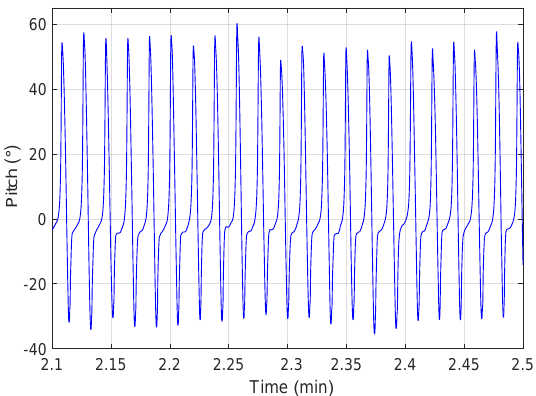
Figure 3. The blue curve represents the pitch angle estimation of a shoe-mounted sensor when walking horizontally. Each maximum of the pitch estimation corresponds to one